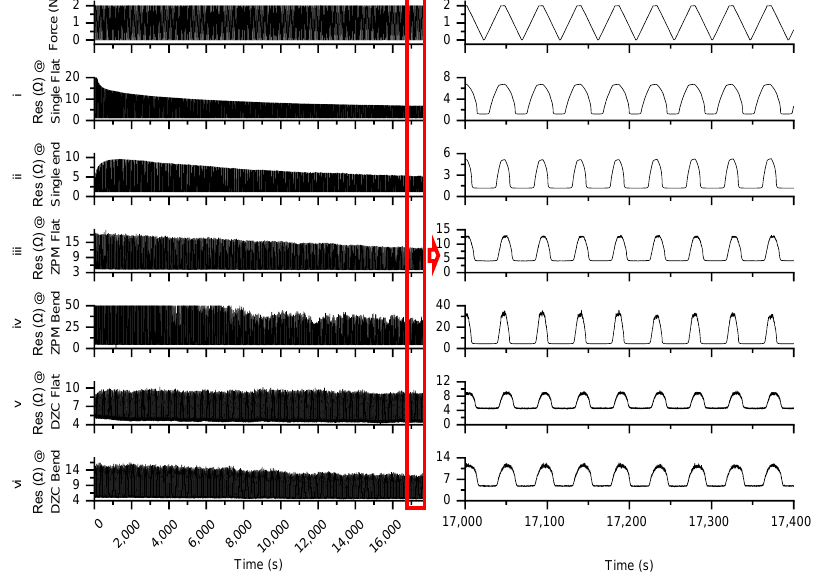
Figure 15. Five hours of measurement results.